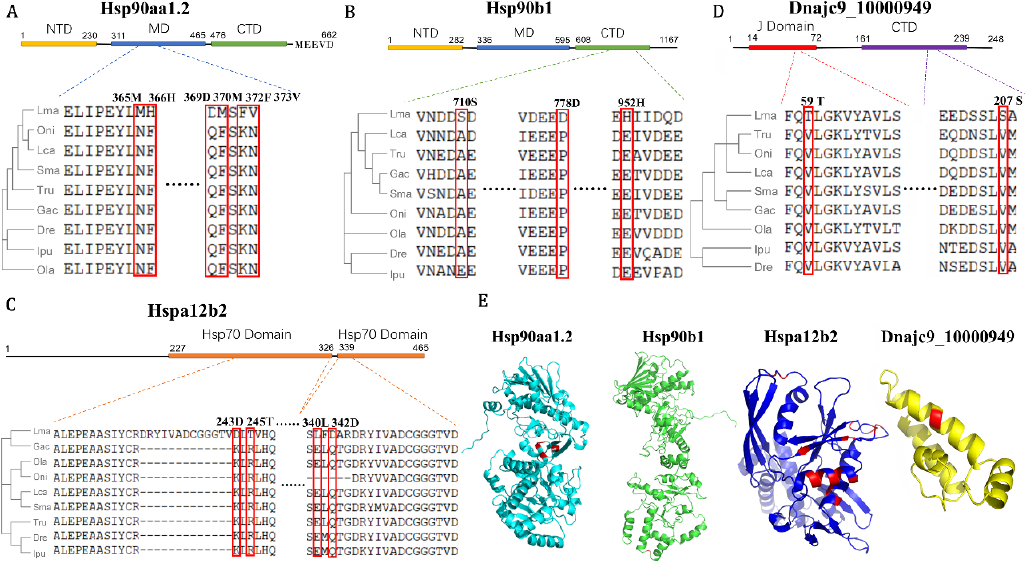
Figure 7. Examples of positively selected sites (PSSs) in ( A ) Hsp90aa1.2 , ( B ) Hsp90b1 , ( C ) Hspa12b2, and ( D ) Dnajc9 functional domains from branch-site model tests. The partial aa sequence alignments of the selected vertebrates with their phylogeny are presented. Red frames indicate PSSs detected with their location at the bar above. Omitted multiple sequence alignment between the two segments are represented by dots. NTD, N-terminal domain; MD, middle domain; and CTD, C-terminal domain. ( E ) Schematic diagram of 3D structure of the above-mentioned LmHsp members with PSSs labeled in red. Only 710 S was predicted in the Hsp90b1 3D structure.